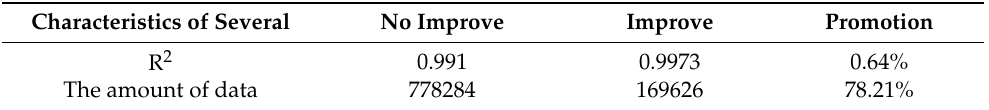
Table 1. Performance table of improved